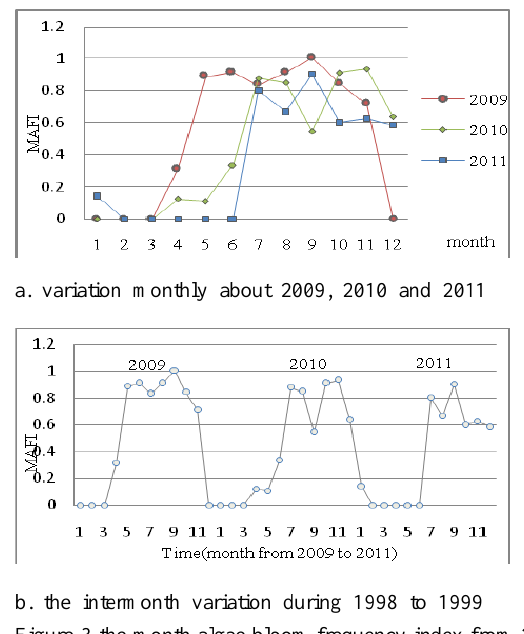
Figure 3 the month algae bloom frequency index from 2009 to 2011 in Taihu Lake Figure 5 reflects the annual variation of MAFI from 2009 to 2010 years. Obviously, the Curve of 2009 has formed a blooming cycle just only in the twelve month of 2009 year (Some research material suggests that blooming cycle in 2008 and 2007 is similar to the situation in 2009) (Ma R et al, 2008; Duan H et al, 2009; Ma R et al, 2010). The blooming cycle in 2010 had extended to the January, 2011. Similarly, the value of December, 2011of Curve not fall to zero, which could show that the blooming cycle had extended to the January, 2012(In fact, the existing monitoring results in January, 2012 show that the booming had happened).